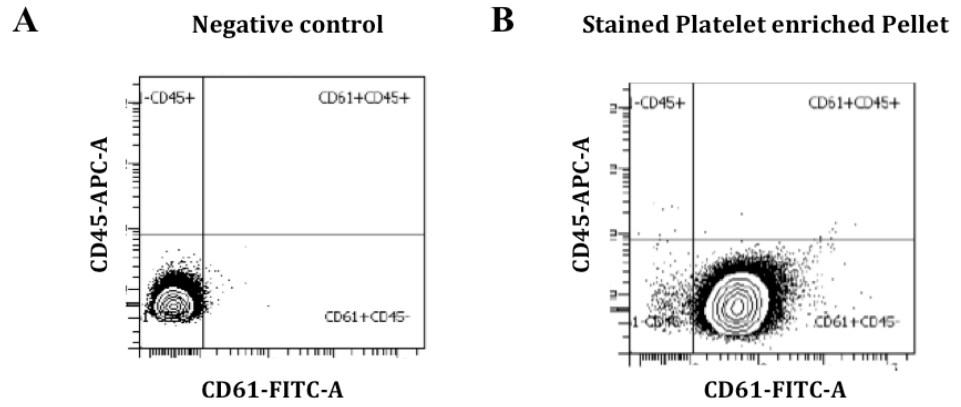
Figure 2. Platelet-rich pellet characterization by flow cytometry. CD61 staining was performed to identify platelets and CD45 was used as a leukocyte marker for staining of leukocyte contamination. Negative control with no CD61 staining ( A ); CD61-positive and CD45-negative staining is observed in the platelet-rich pellet ( B ).